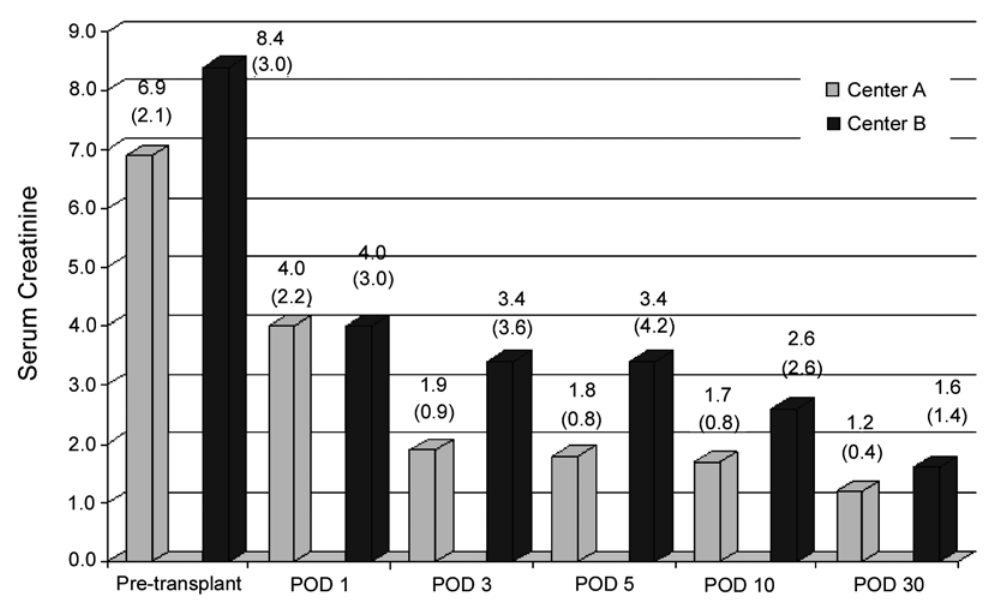
Figure 4 – Receptors data. Serum creatinine pre- and